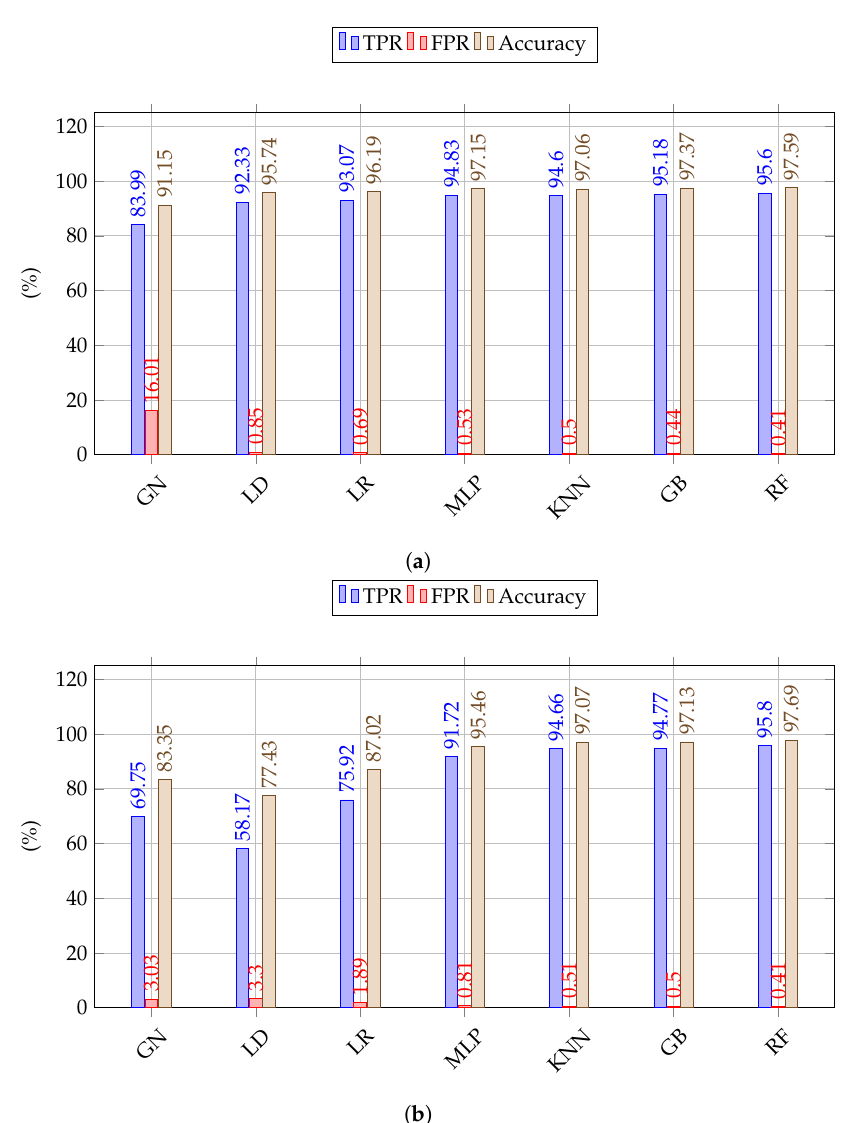
Figure 7. Results of different classifiers for malware categorization ( a , b ) problem. ( a ) Full features; ( b ) selected features. Table 2. Training and average testing time of all chosen classifiers for malware categorization